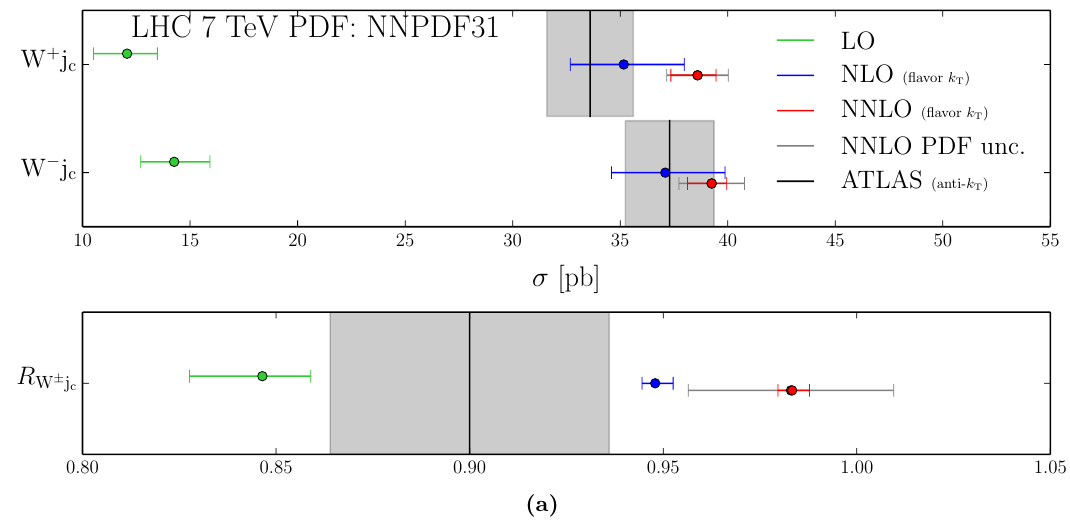
, pp → W − j , and the ratio R at the LHC with W ± j c c c = 0 is cd 6 algorithm and the T T